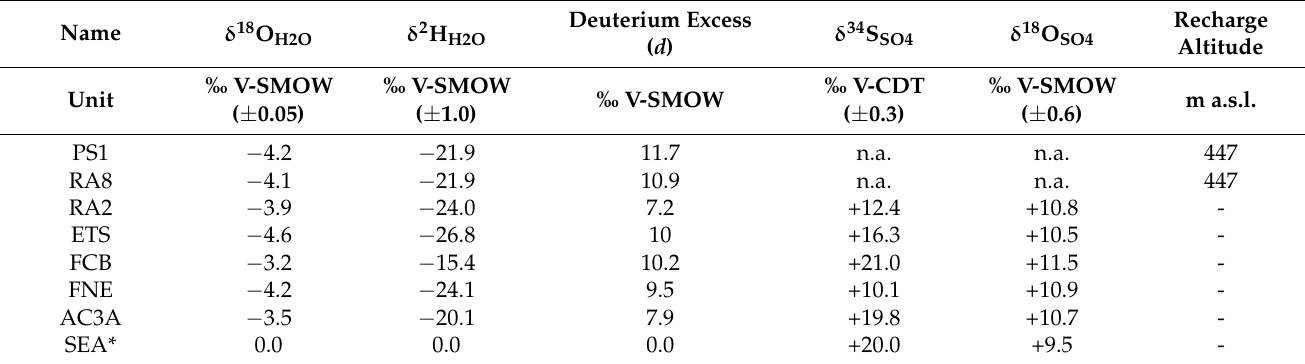
Table 2. Stable isotope values and preferential recharge altitude; n.a.—not